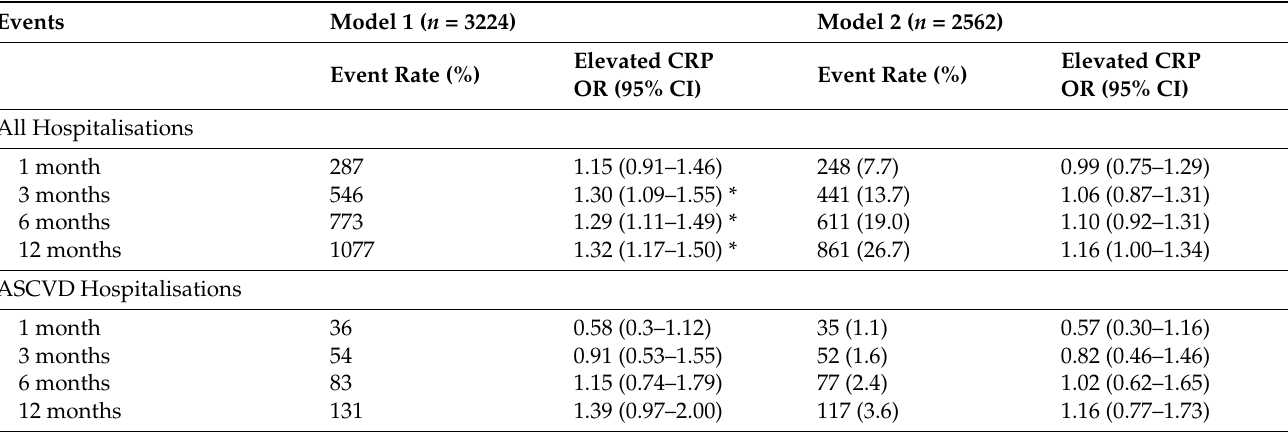
Table A10. Association of elevated CRP levels ( ≥ 2 mg/L) with different hospitalisation